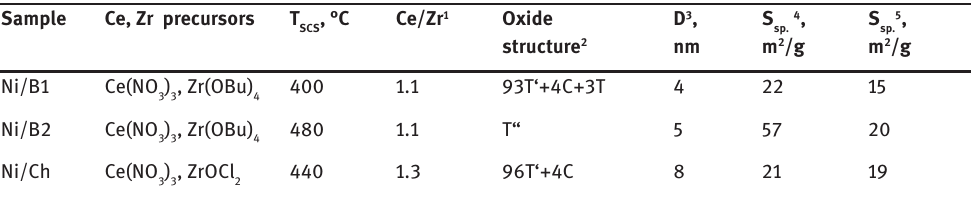
Table 1: The synthesis conditions, phase compositions and textures of Ni/Ce-Zr-O samples. Sample Ce, Zr